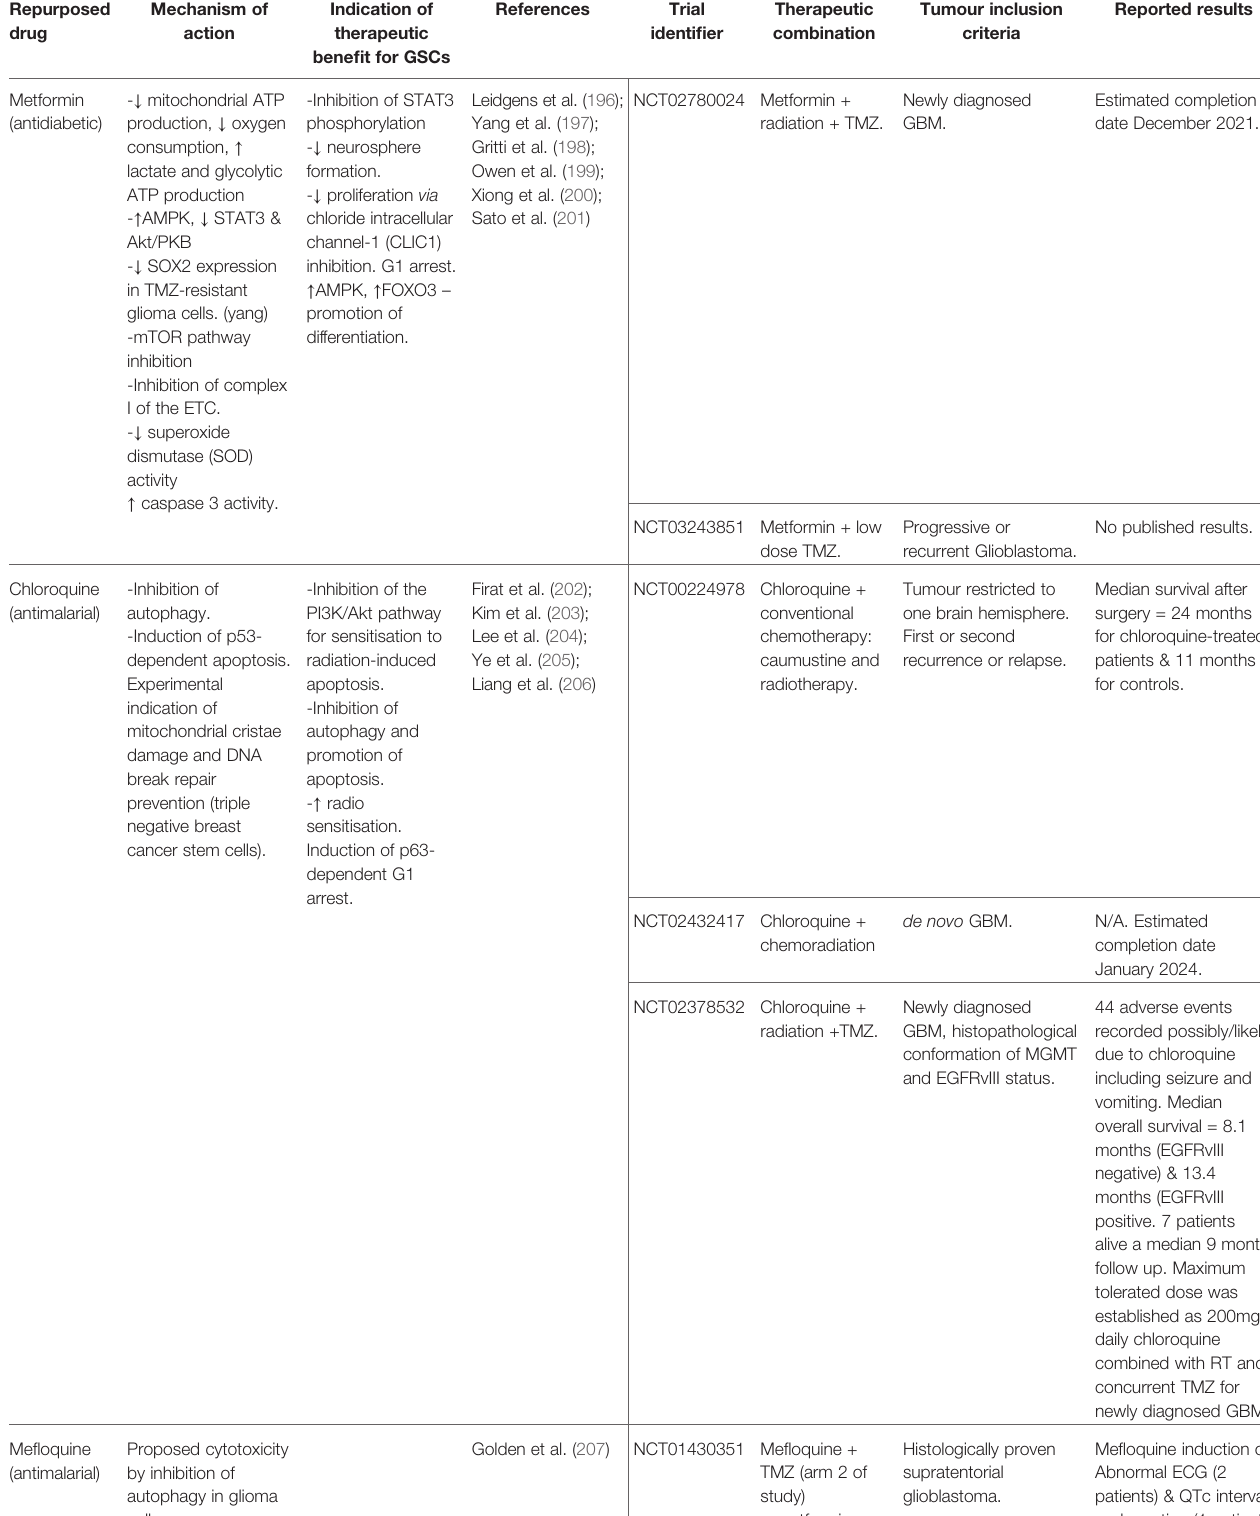
TABLE 1 | Repurposed drugs currently in clinical trials for the assessment of ef fi cacy against